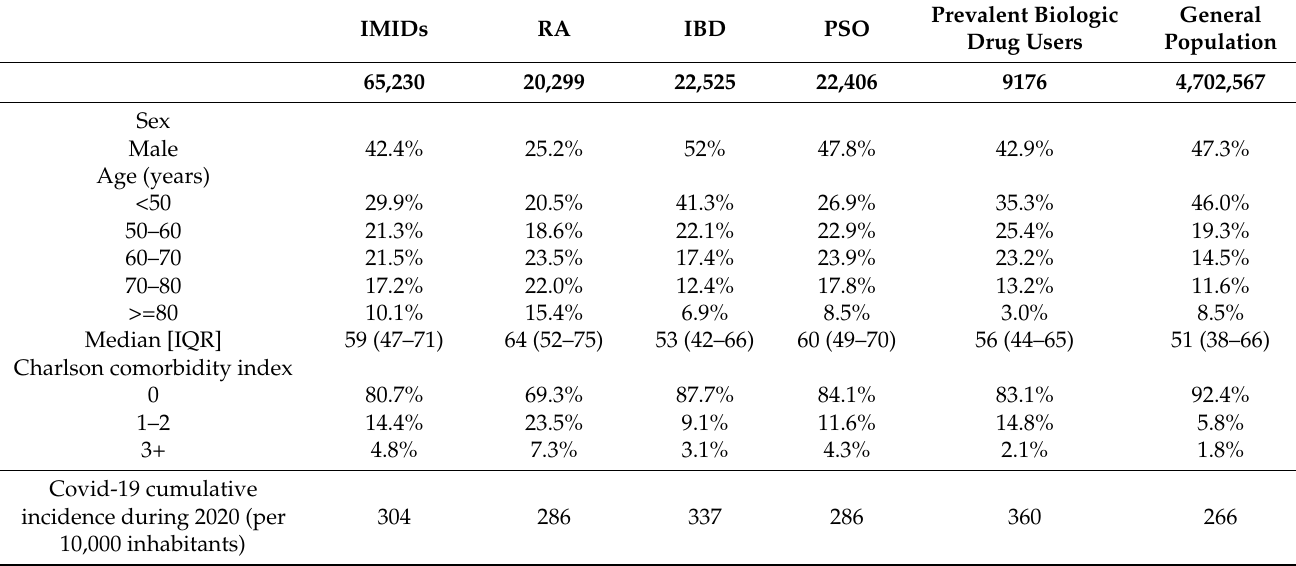
Table 1. Immune-mediated inflammatory disease (IMDs) cohort